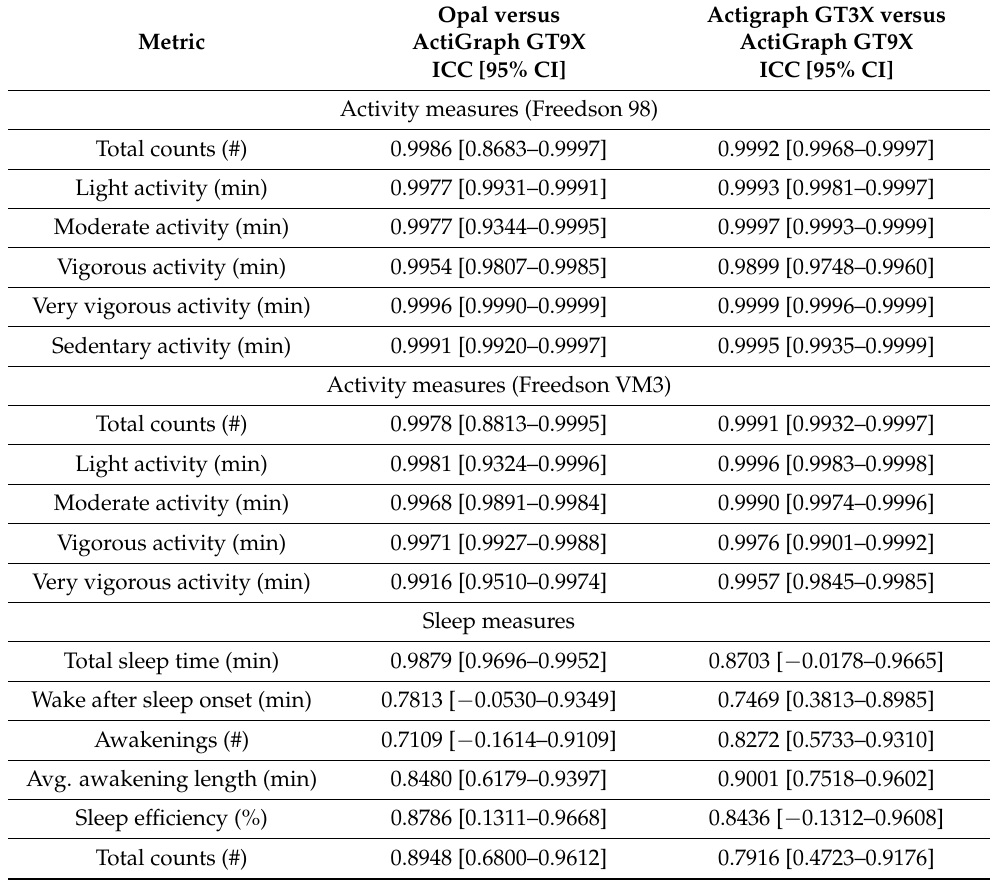
Table 1. ICC (two-way mixed effects, absolute agreement) for activity and sleep